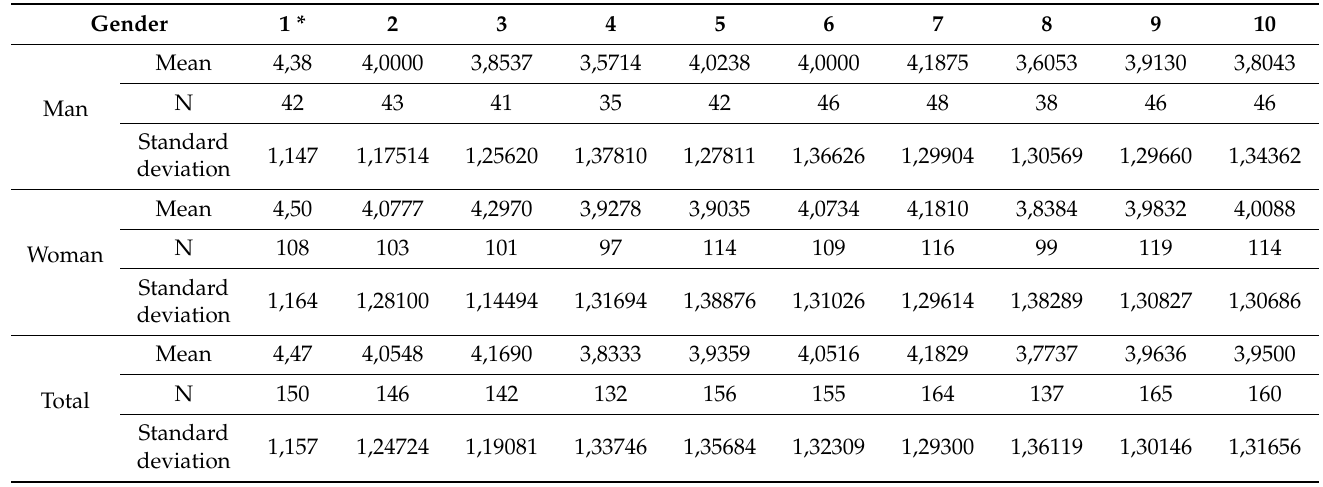
Table 2. Preference for a particular type of onboarding among women and men.